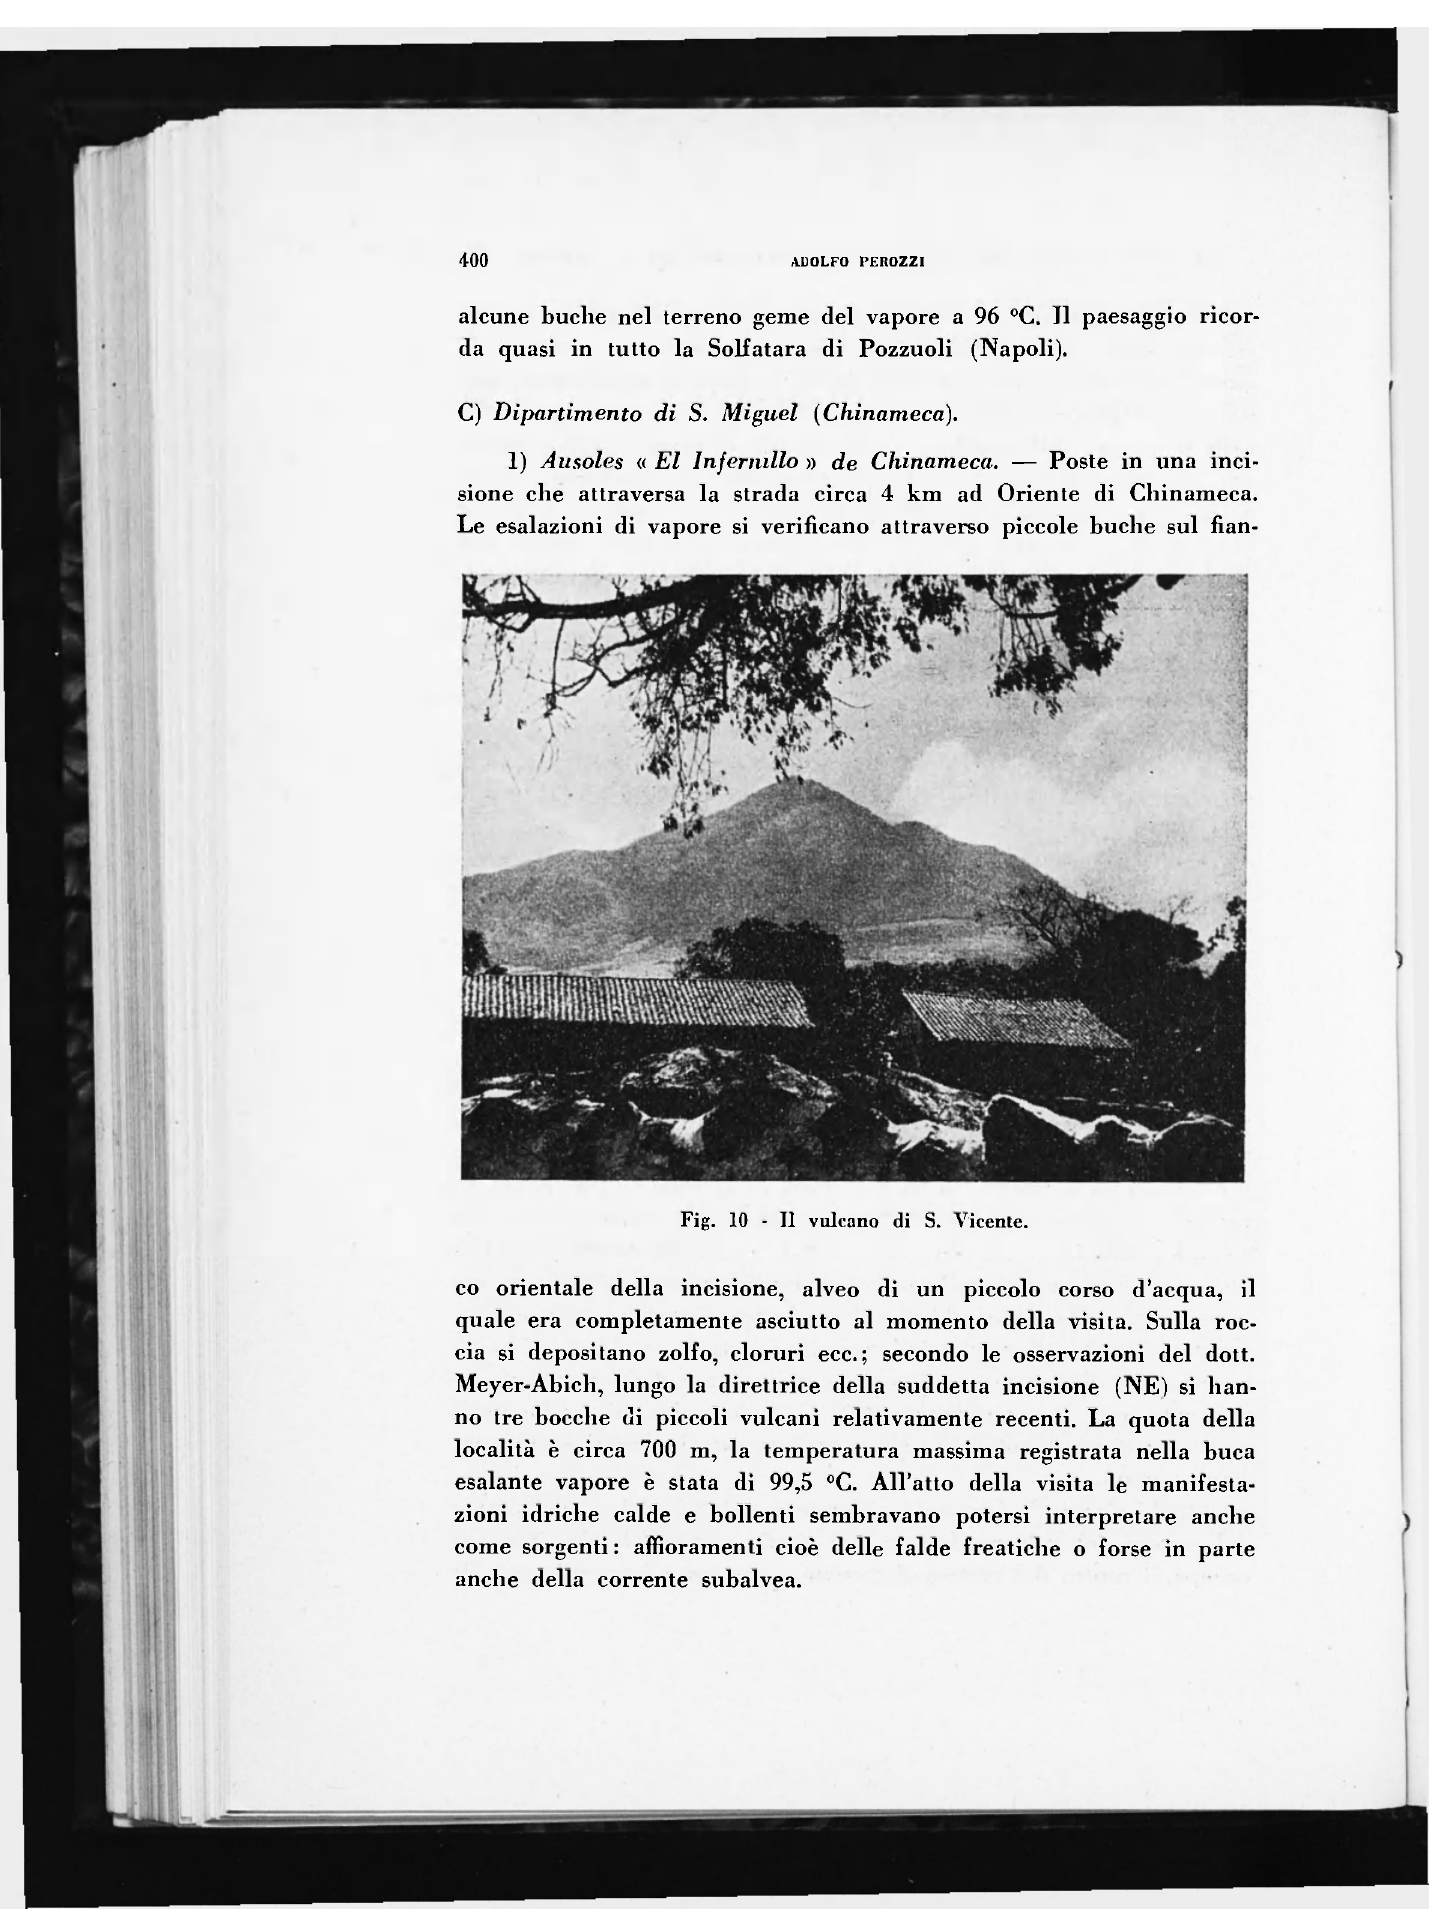
Fig. 10 - Il vulcano di S.